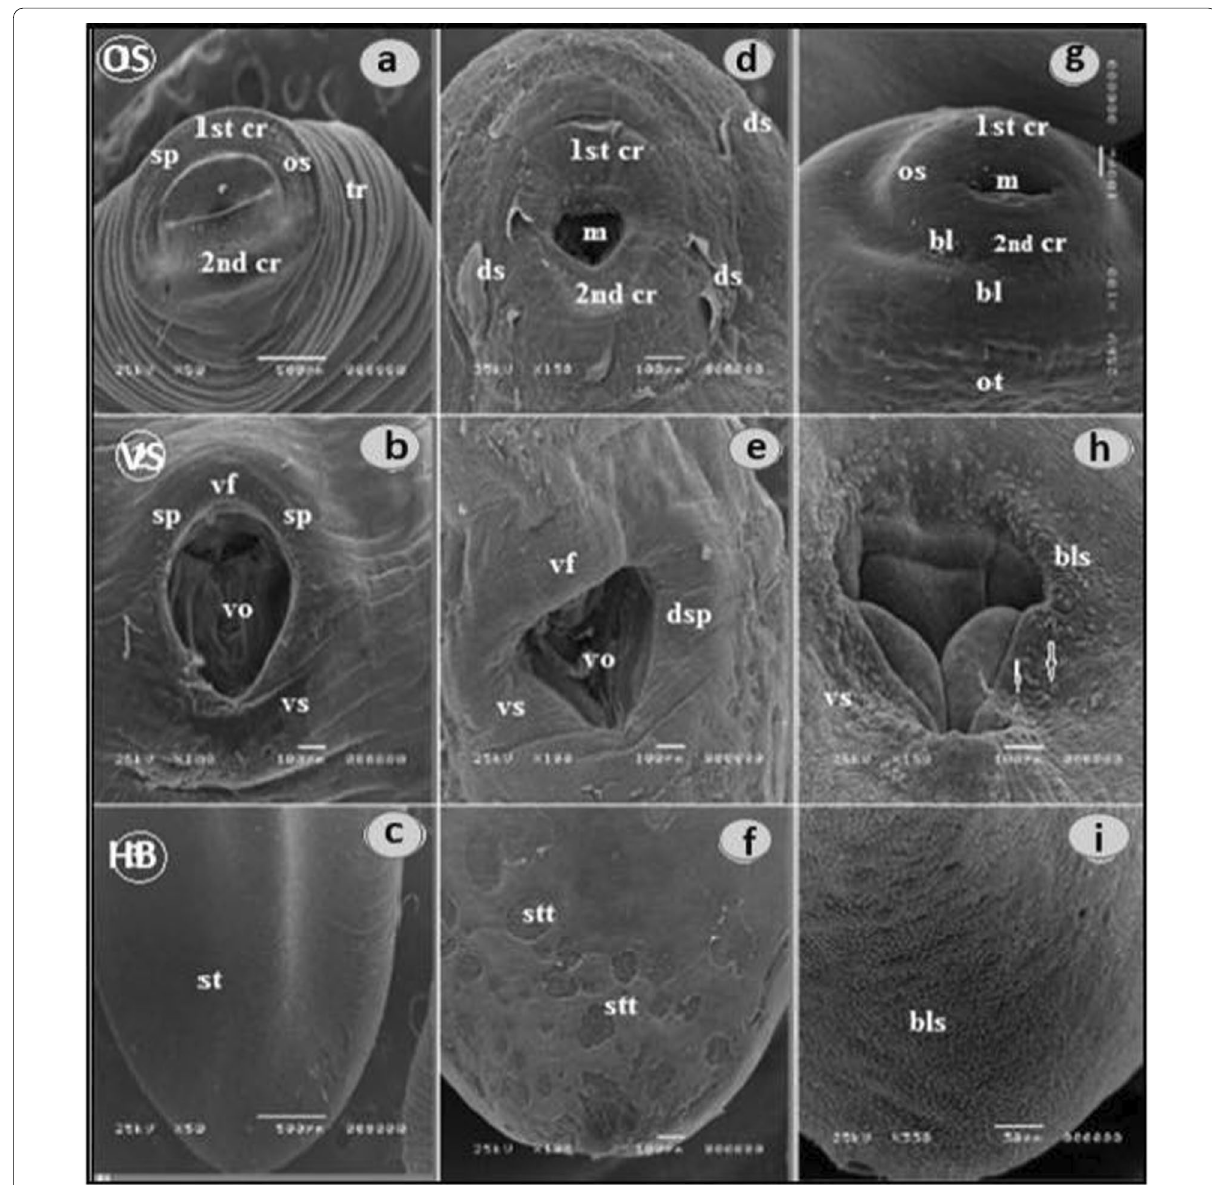
Fig. 3 SEM micrograph of C. phalacrocoracis metacercaria. a–c Unexposed control group; a fore body tegumental surface exhibited; distinct transverse annulation (ts), first collar‑like ring; semicircular shape (1st cr) and second flat shaped (2nd cr), sensory papillae (sp). b A large ventral sucker (vs), ventral spongy fold (vf), sensory dome like papillae (sp). c Hind body exhibited smooth normal tegument without spines (st). d–f Exposed worm to V. alternifolia extract; d oral sucker showed disappearance (ts), desquamated tegument (ds), and disfigured collar‑like rings e ventral sucker exhibited thicker vf, disappeared of dome like papillae (dsp) surrounded the ventral sucker. f Hind body exhibited detached and starched tegument (stt). g–i Exposed worm to M. piperita extract; g apical view of oral sucker exhibited; edematous tegument with completely disappeared (tr), collar‑like ring (cr) and ejection of blebs (bl). h Ventral sucker showed a thinner ventral fold and ejection of blebs (bl). i Hind